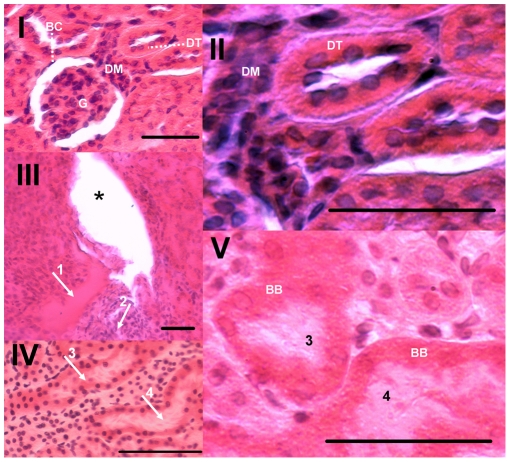
Histopathological features of renal samples.Slides of hematoxilin-eosin stained sagittal sections from representative kidneys of mice treated with: I and II: vehicle (control); see normal appearance of Bowman's capsule (BC), glomerulus (G), macula densa (DM) and distal tubule (DT); III, IV and V: C. d. terrificus venom; the most frequently changes detected were edema (*), fibrosis (1) with cell influx (2), and tubular necrosis with tubules markedly dilated and cellular debris in the lumen (3, 4) and in the brush border (BB). Treatments of envenomed with allopurinol or probenecid acted indistinguishably to ameliorate the frequency and the intensity of detectable histological changes comparatively with untreated envenomed mice. Bars = 100 µm.